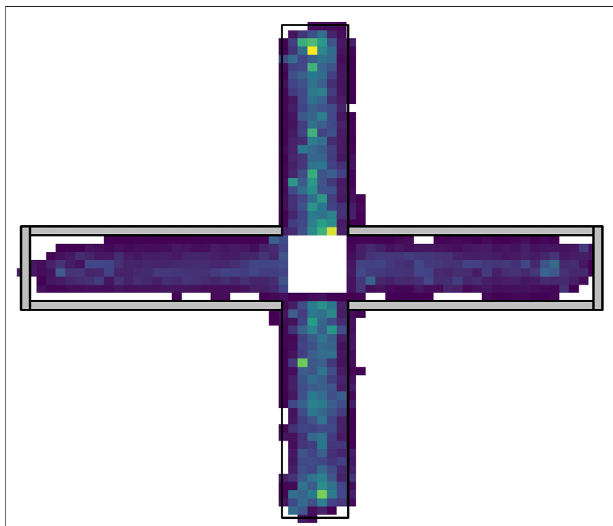
FIGURE 2 | Heatmap of motion tracking data of study 1 using every fi fth recorded data point during the exploration phase ( N (cid:1) 30). Areas with lighter colors depict areas with greater activity. The center area is de fi ned as transition zone, thus excluded from analyses.